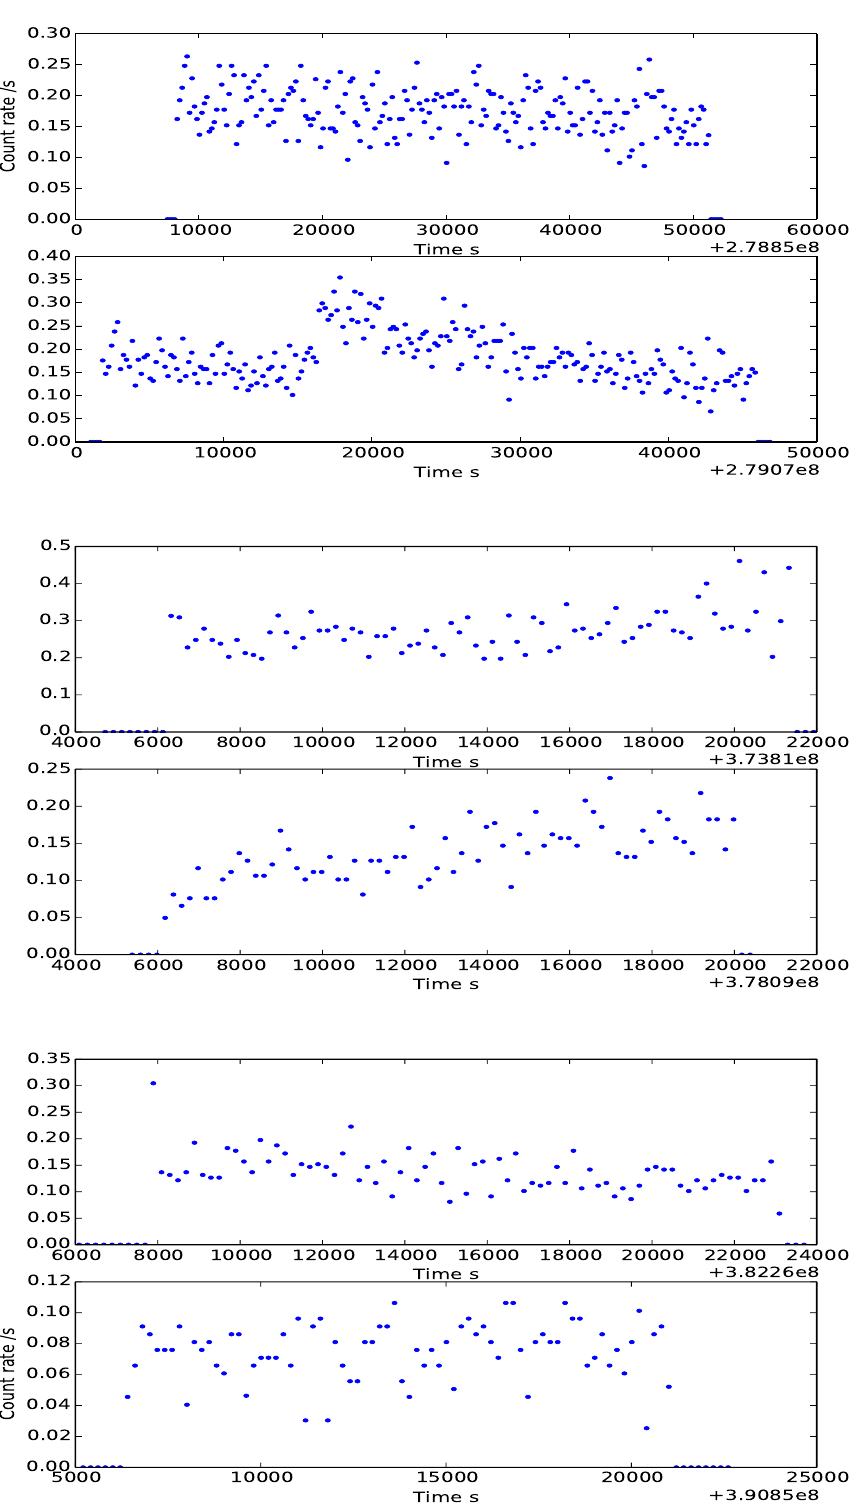
Figure 2. Each panel shows the light curve of TV Cassiopeia from one of the six Chandra observations in the order of: 07082, 08458, 11080, 11081, 11082, 11084. Typical errors of the count rates are 0.02 s − 1